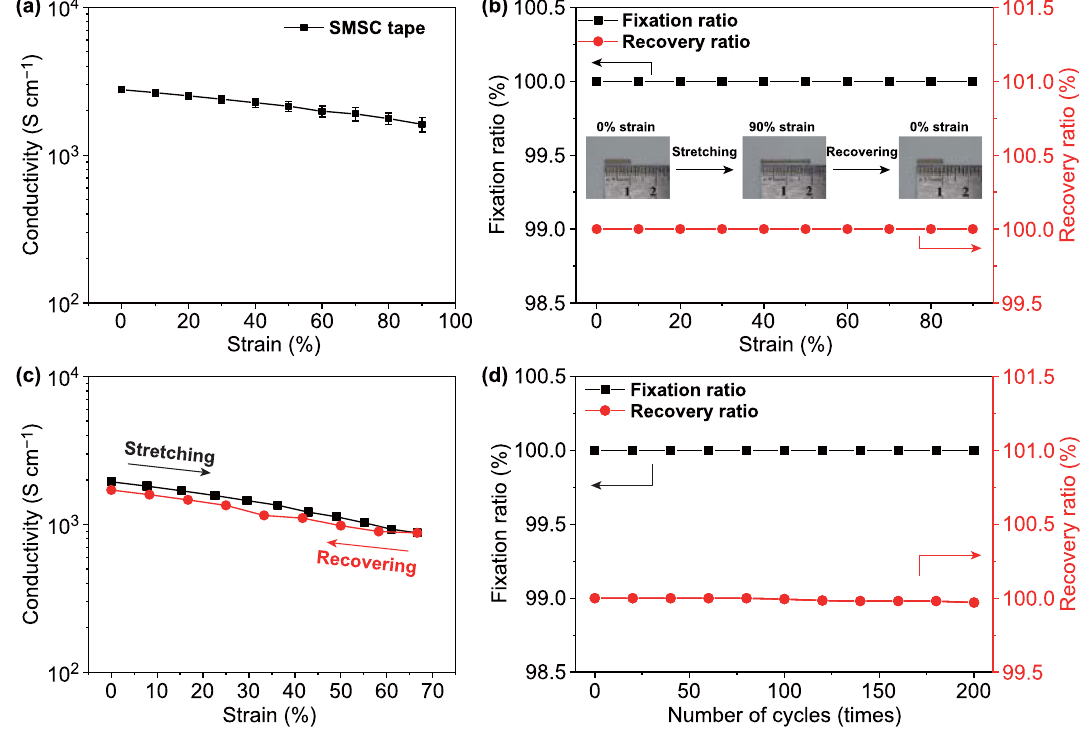
Fig. 3 Shape-memory performance of SMSC tape. a Conductivity of SMSC tape at room temperature as a function of tensile strain. b R f and R r of shape fixing and recovery of SMSC tape at different tensile strains. c A cyclic conductivity-strain test is carried out using SMSC tape at maximum strain of 66.7%. d R f and R r of cyclic shape fixing and recovery of SMSC tape at tensile strain of 50%. The mass ratio between SA and UDA is 70:30. The mass fraction of Ag NPs and BPO is 80% and 0.14%, respectively. The annealing temperature is 150